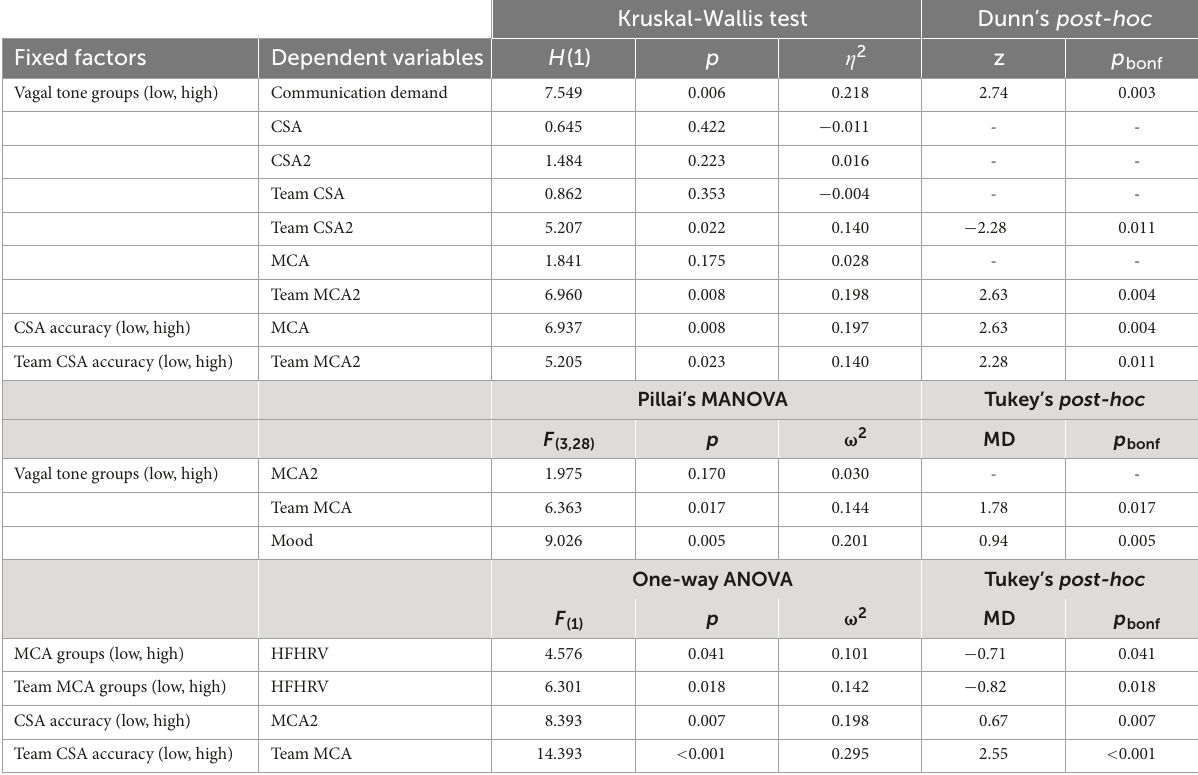
TABLE 3 Comparison of differences between groups ( N =